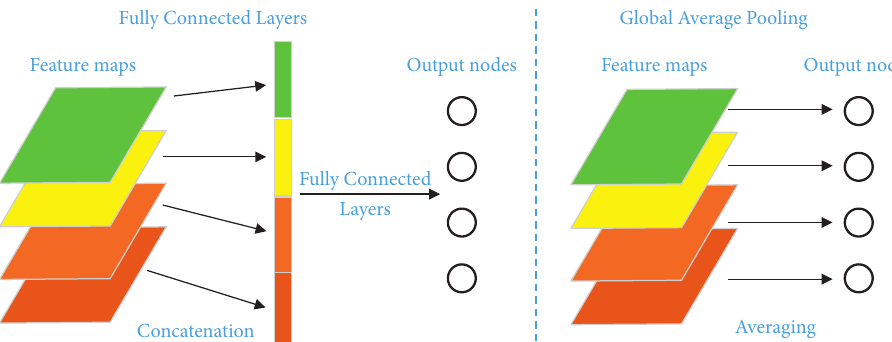
Figure 2: Comparison between the full connection layer and global average pooling layer.